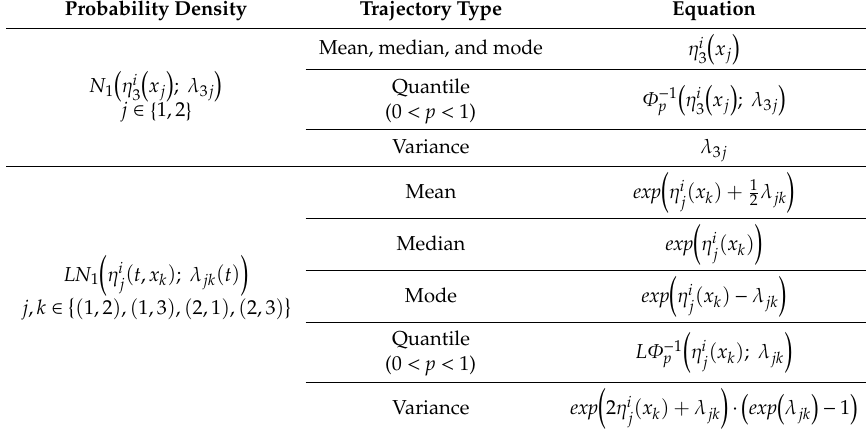
Table 9. Stationary conditional mean, median, mode, p -quantile (0 < p < 1), and variance trends with one predictor.